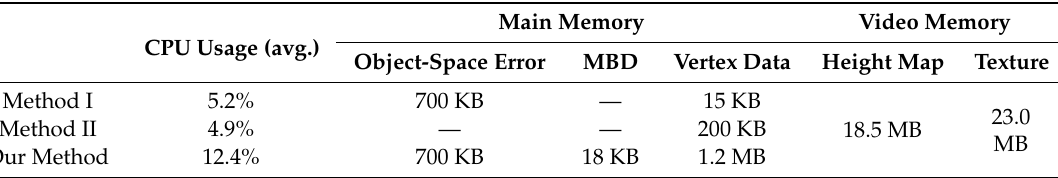
Table 4. CPU usage and memory consumption of the three methods using a 4097 × 4097 height map in Area I. Main Memory Video Memory CPU Usage (avg.) Object-Space Error MBD Vertex Data Height Map Texture Method